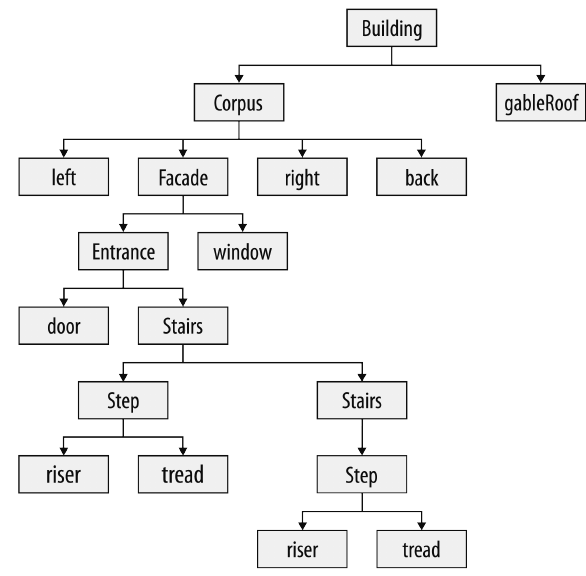
Figure 2: A possible derivation tree of a context-free gable roof building